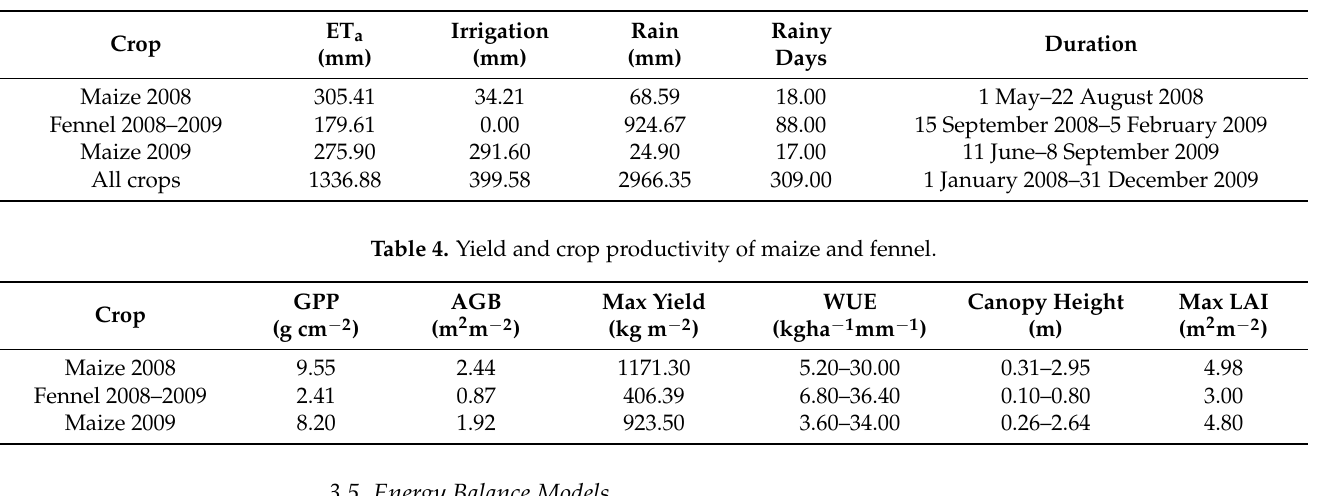
Table 3. Sum of rain, irrigation and ET a for the period 2008–2009.